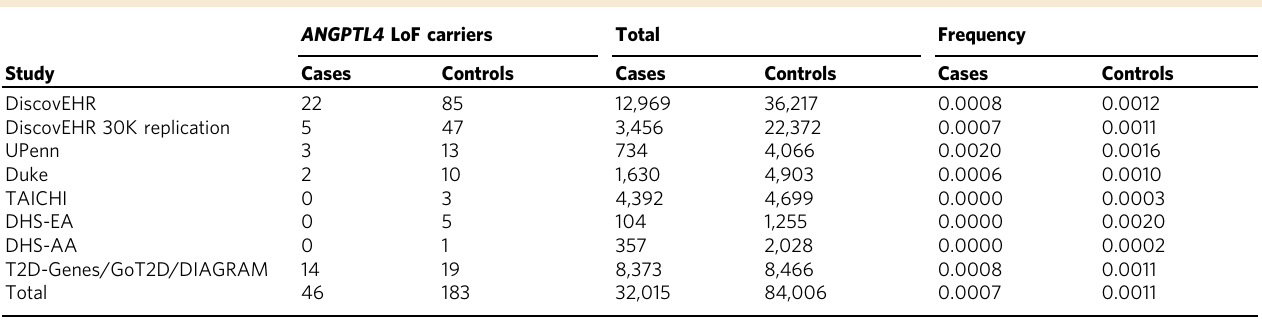
AA African American, CI con fi dence interval, Duke Duke CATHGENcohort, EA European American, TD2-Genes/GoT2D/DIAGRAM combined analysisof T2D-GENES,GoT2D and DIAGRAMstudies, pLoF predicted loss-of-function variant, Penn University of Pennsylvania Medicine Biobank, TAICHI TAIwan MetaboCHIp consortium The overall odds ratio for ANGPTL4 pLoFs and type 2 diabetes risk, using a two-sided exact conditional test, was 0.71 (95% CI 0.49 – 0.99, p = 0.041) error (SE) 0.047, p = 0.002) and higher insulin sensitivity index